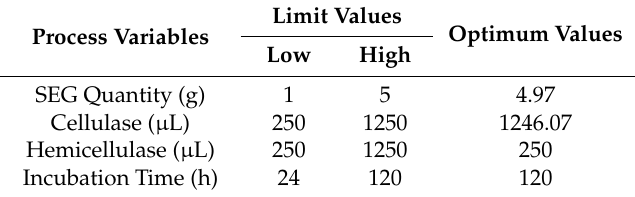
Table 4. Low, high, and optimum values for the process variables used in this study.